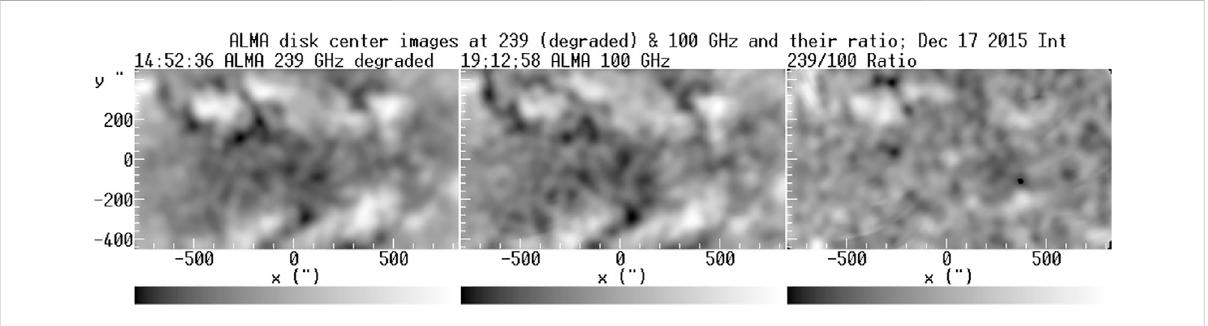
FIGURE 5 A region near the center of the disk observed with ALMA in full-disk mode on 17 December 2015: Degraded 239 GHz image, 100 GHz image, and their ratio. Values range from 6000 to 7380 K, 6860 – 8380 K and 0.83 to 0.93, respectively. From Alissandrakis et al. (2017), reproduced with permission ⓒ